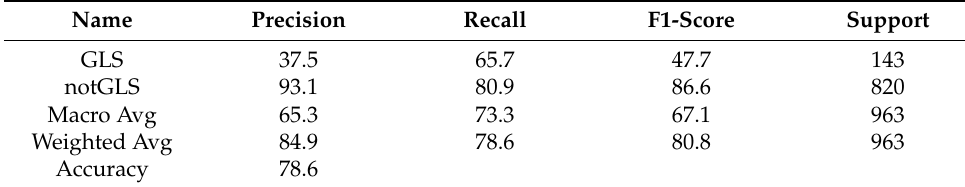
Table 6. Performance of GLS_net upon the PV testing